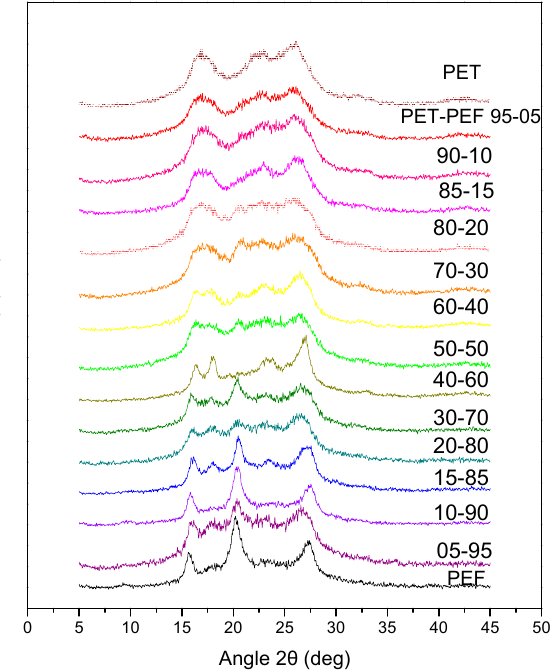
Figure 1. Wide-angle X-ray diffractometry (WAXD) patterns for the blends and for the PEF and PET homopolymers and their blends at different compositions as indicated.